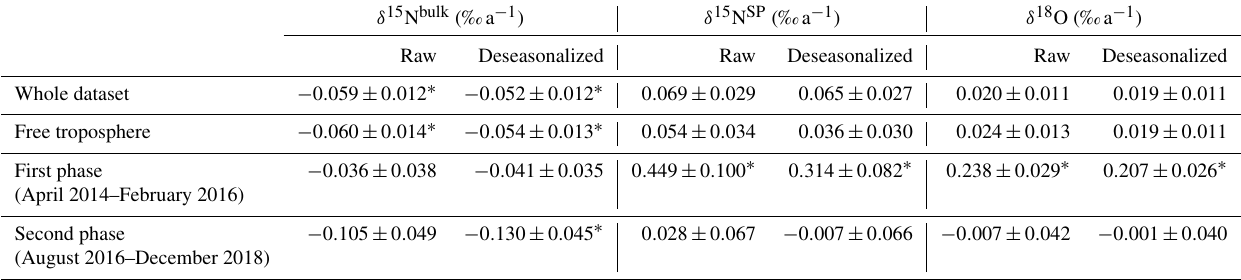
Table 3. Trends of atmospheric δ 15 N bulk , δ 15 N SP and δ 18 O at Jungfraujoch determined using discrete measurements between April 2014 and December 2018. The trends are determined for the whole dataset, the dataset filtered for free troposphere (removing data points with significant influence from the plenary boundary layer) and the second-phase dataset with biweekly measurements (August 2016 to December 2018).